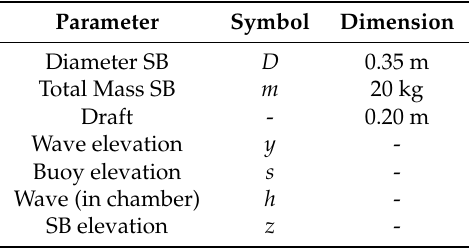
Figure 6. ( a ) The vertical position for the wave in the chamber and the buoy. ( b ) Instantaneous power and the relative position between the water surface in the OWC chamber and the buoy. ( c ) Cumulative energy production over 1 h. Table 3. Parameters for the small